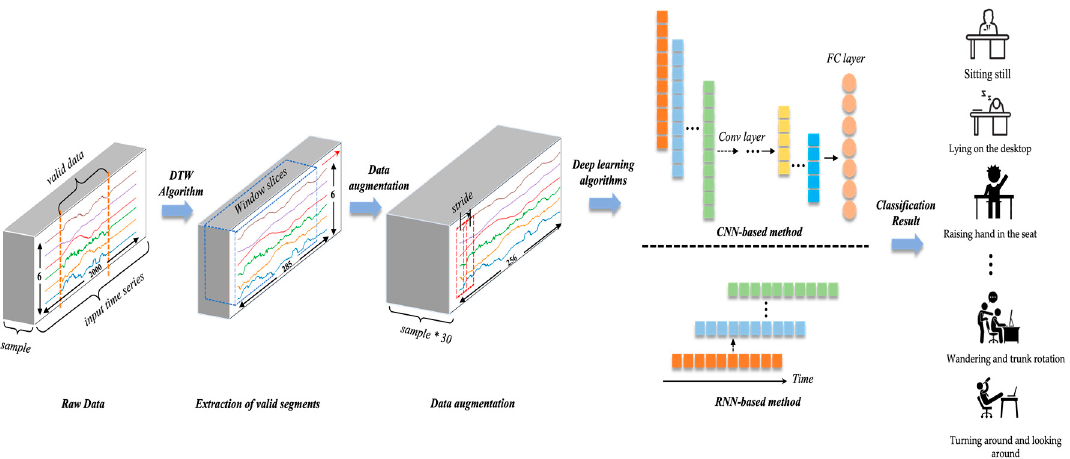
Figure 5. The framework of the whole process of the algorithm. The algorithm takes raw data as the input and outputs the most likely behavior from the 14 common classroom